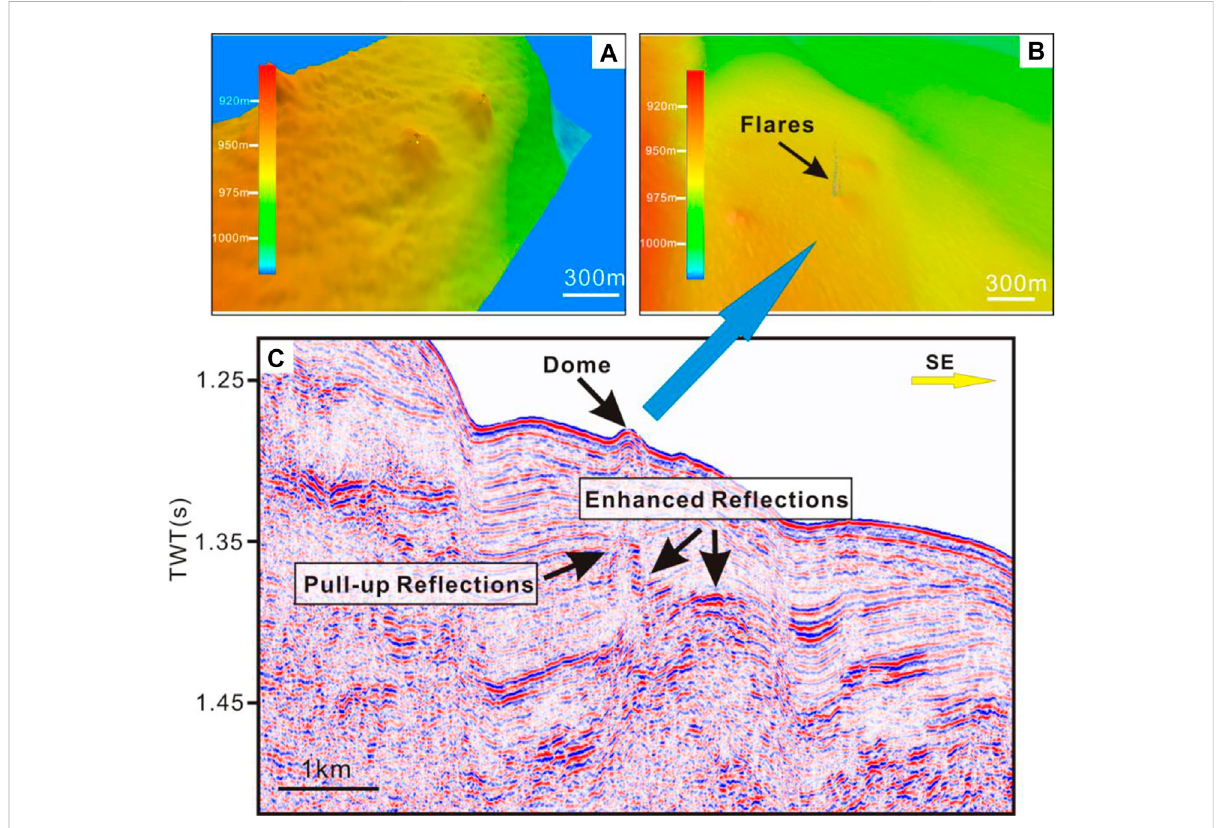
FIGURE 11 Multibeam data and seismic pro fi le show a dome. (A) and (B) Bathymetry data show fl are above the dome. (C) The seismic pro fi le data of the dome. Several amplitude anomalies such as pull-up re fl ections and enhanced re fl ections were observed around the feeder zone of the dome. See locations in Figure